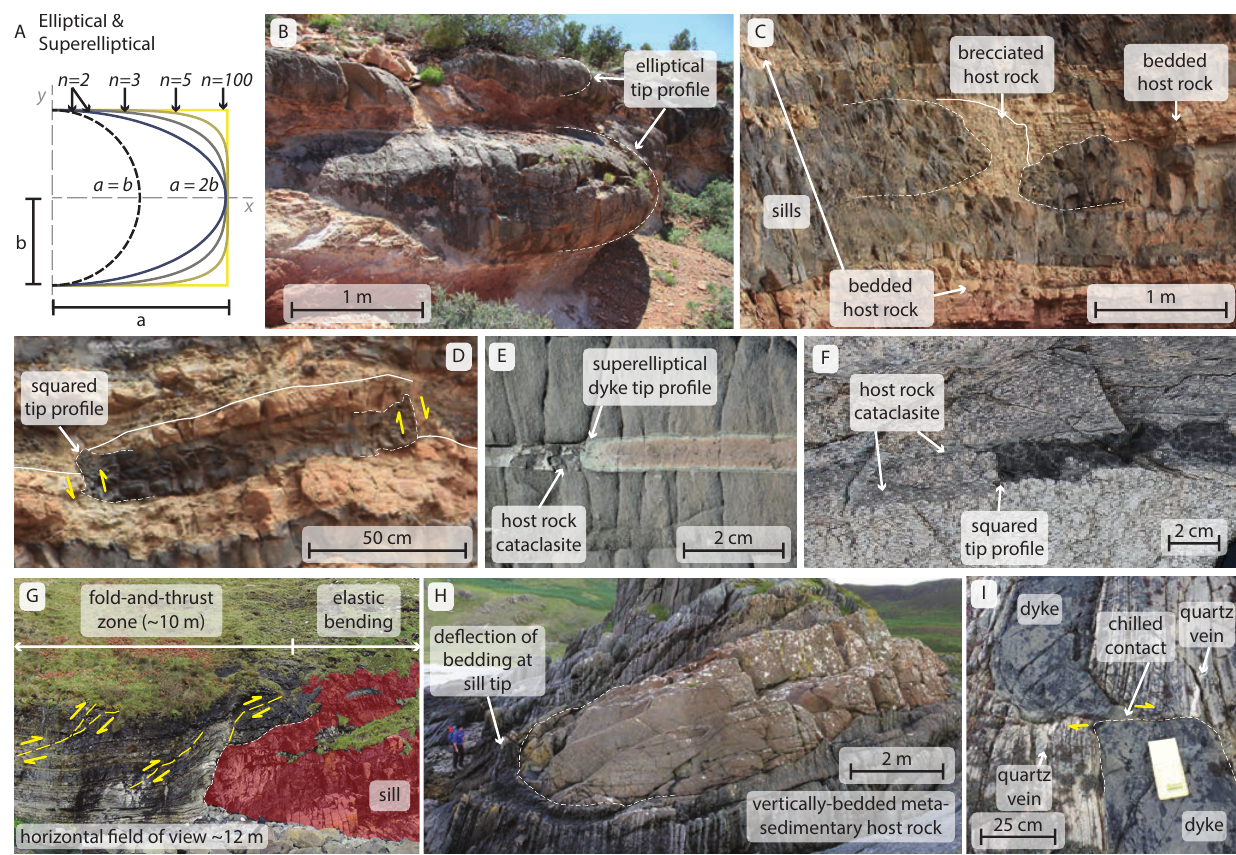
Figure 2: Examples of elliptical to superelliptical sheet intrusion tip geometries. [A] Idealised tip form for elliptical